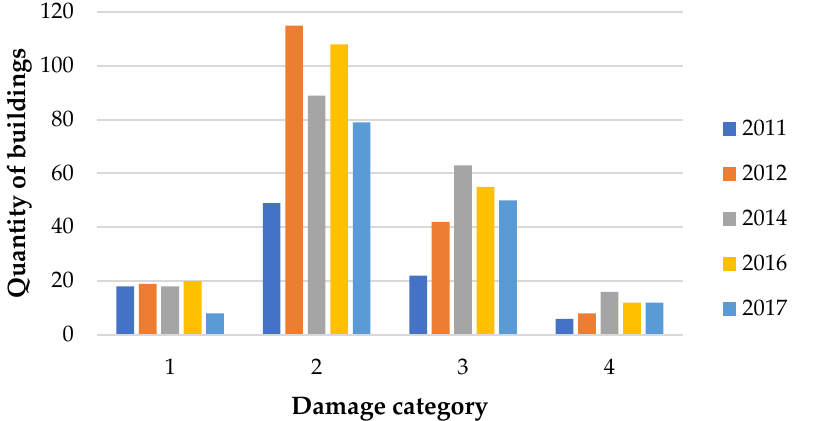
Figure 20. Distribution of data for the variable relating to building damage categories in different years.